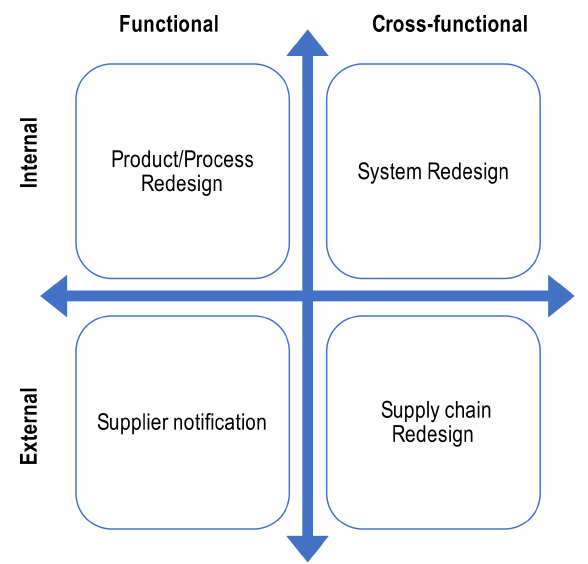
Figure 6. Proposed problem focusing matrix (PFM): the focus can be internal or external to the organization and it can be focused (functional/operative) or defocused to include multiple functions (cross-function/systemic